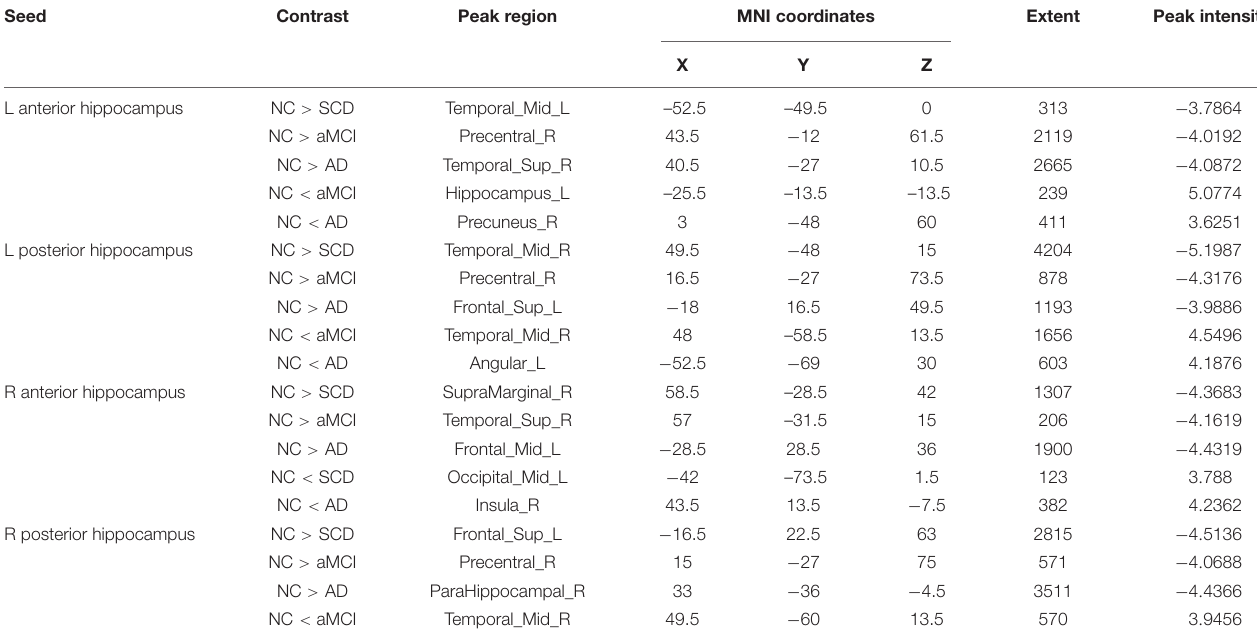
TABLE 3 | Significant between-group (NC-SCD, NC-aMCI, and NC-AD) differences in structural covariance networks seeding from anterior and posterior hippocampi. Seed